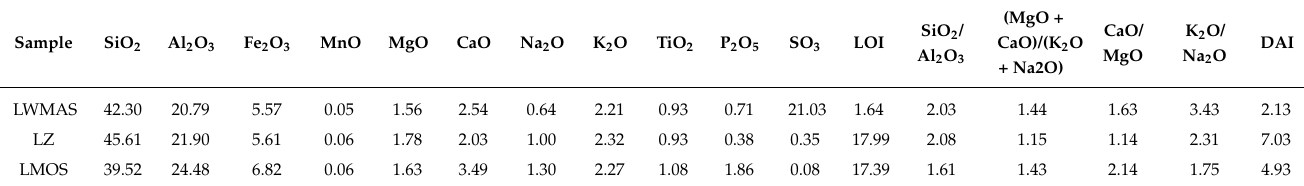
Table 3. The main chemical components’ contents in the tested ash samples (in